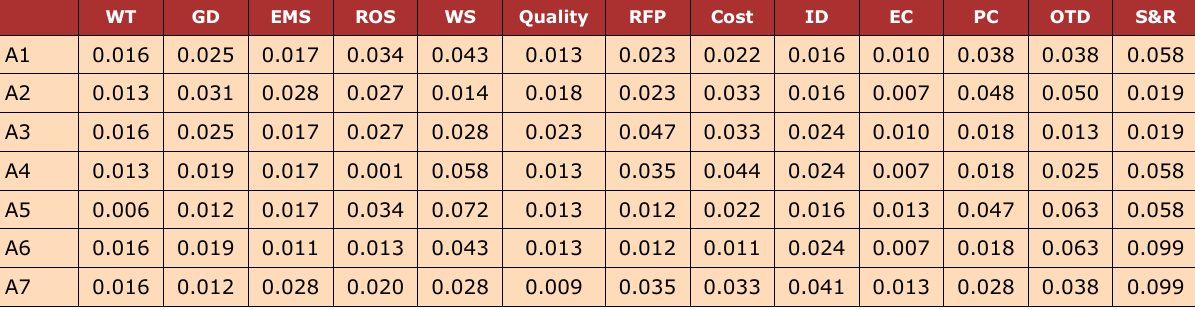
Table 13 showing weighted normalized decision matrix was drawn using Equation (19) and information/ data on Table 12 .